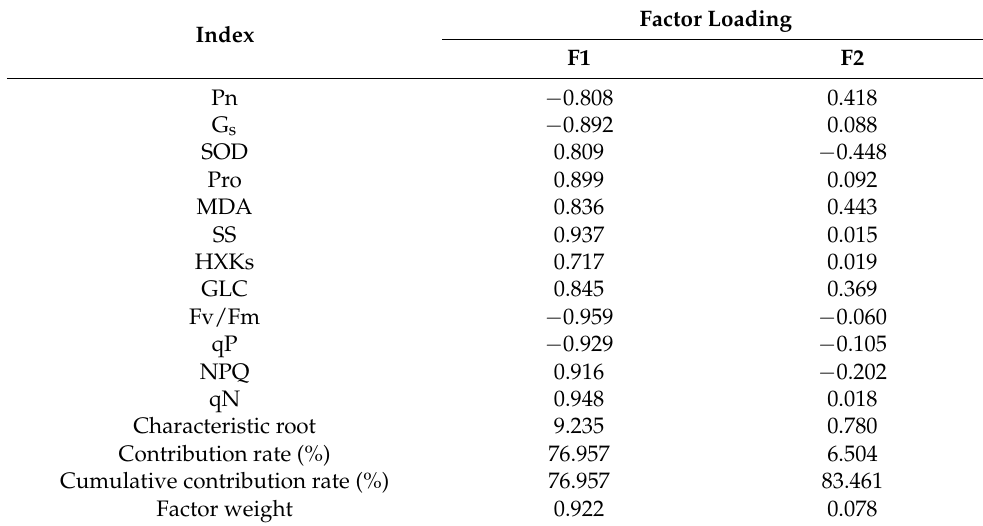
Table 3. Eigenvectors and rates of contribution of the principal components for each index.